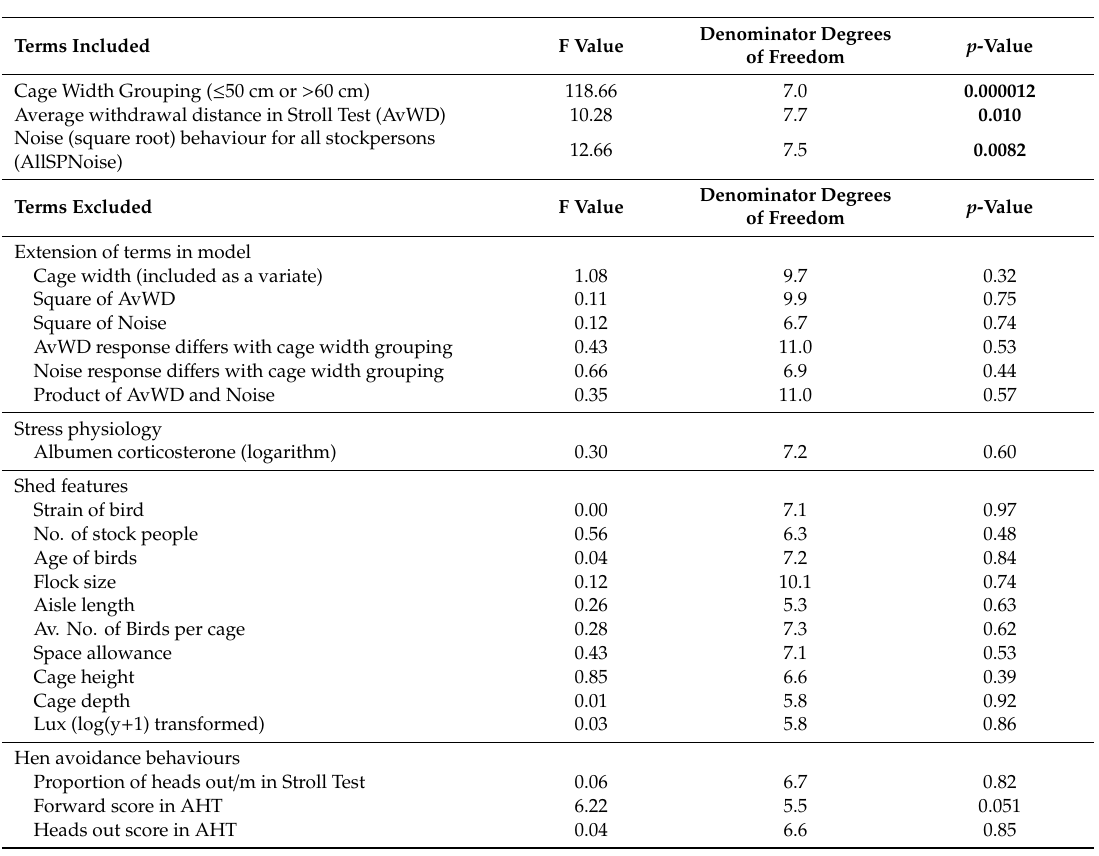
Table 4. Tests for including and excluding fixed e ff ect terms in the model relating 5% peak egg production duration to physical features of the laying house, hen avoidance behaviours and all stockperson behaviours. Tests for the inclusion of terms for main stockperson behaviours and attitudes of main stockperson had p > 0.05, and thus are not presented. All Wald F tests have 1 numerator degrees of freedom. A transformation in parentheses after a term indicates that the variable was examined for inclusion / exclusion in the model after the variable had been transformed, so as to reduce skewness of the